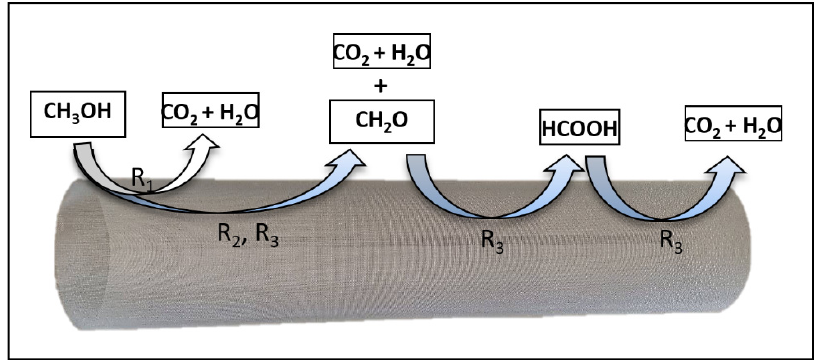
Figure 7. Series-parallel reaction pathways for methanol photoconversion into CO 2 , on the